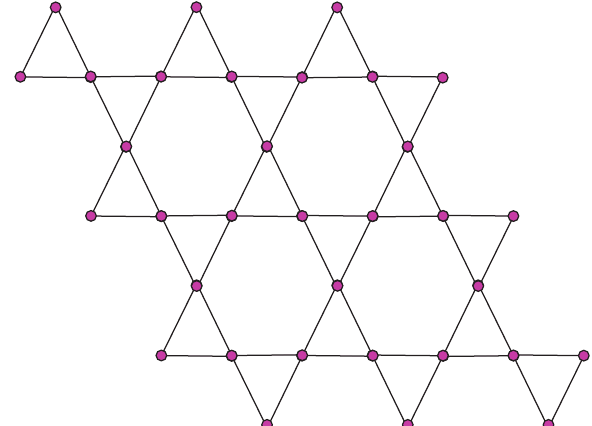
Figure 2: Graph of rhombus oxide network (RHOX ( t )